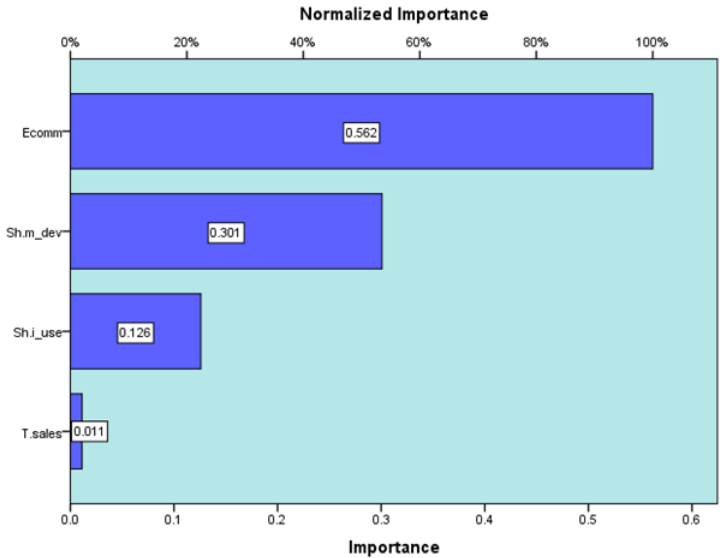
Figure 3. Importance of variables from the MLP model. Source: developed using SPSS v.20.